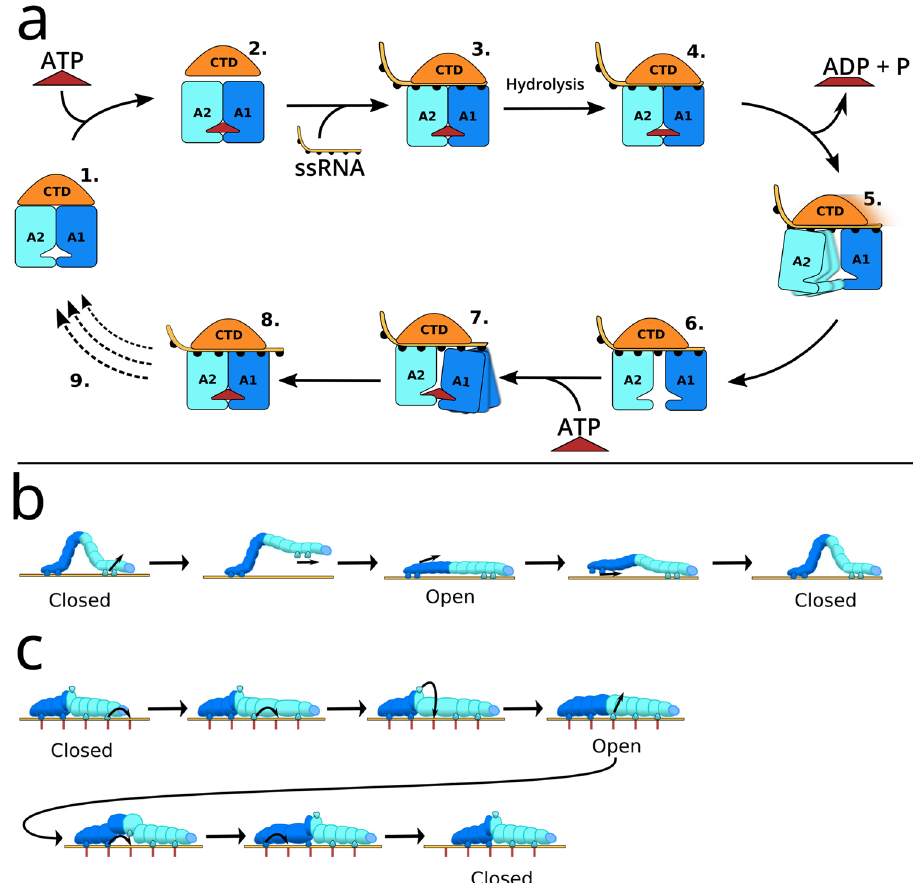
Fig. 6 Mechanism and models of RNA translocation. a Schematic hypothesis of the complete translocation cycle. 1. Apo structure. 2. ATP-binding triggers opening of the CTD/RecA interface, allowing 3. binding of ssRNA and formation of the Protein – ATP – RNA complex, represented by PDB ID 5LTA. 4. ADP bound state after ATP hydrolysis phosphate release. 5. RNA-bound state with open RecA interface and weak RecA2 – RNA contacts. 6. Stable open structure, represented by PDB ID 6I3P. 7. ATP-binding triggers closure of the RecA interface and sliding of RecA1 along the RNA. 8. Protein – ATP – RNA complex translocated by one nucleotide relative to the 3. step. 9. Transition back to the apo-structure after fi nalizing multiple RNA translocations. b The classical inchworm model. c Proposed inchworm/caterpillar model to illustrate both the center-of-mass motion of the RecA-like domains (dark blue and cyan) and the crawling of RecA-like along the RNA. Hydrogen bond partners of protein and RNA are sketched as caterpillar legs and as red lines, respectively. Since the RecA-like domains bind the RNA with four or fi ve H-bonds in the closed and open state, respectively, the caterpillar requires fi ve legs. The central leg, modeling the sensor serine S387, carries out a rotation to bind the free nucleotide binding site before reaching the open